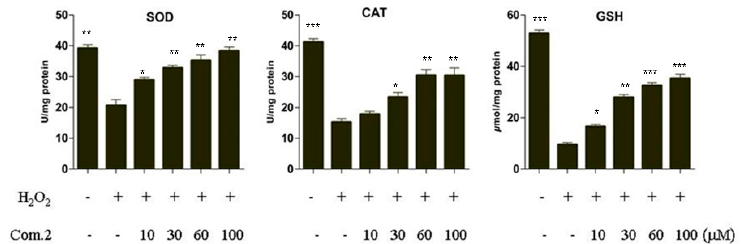
Figure 4. Compound 2 restored superoxide dismutase (SOD) and catalase (CAT) activities and glutathione (GSH) level in MIN6 cells damaged by H 2 O 2 . Cells were treated with various concentrations of compound 2 for 4 h, then exposed to 200 µ M H 2 O 2 for 12 h. SOD, CAT, and GSH were measured with microplate. Data are presented as means ± SDs of three independent experiments. * p < 0.05, ** p < 0.01, *** p < 0.001 compared with com.2 (0 μ M) in 200 μ M H 2 O 2 .